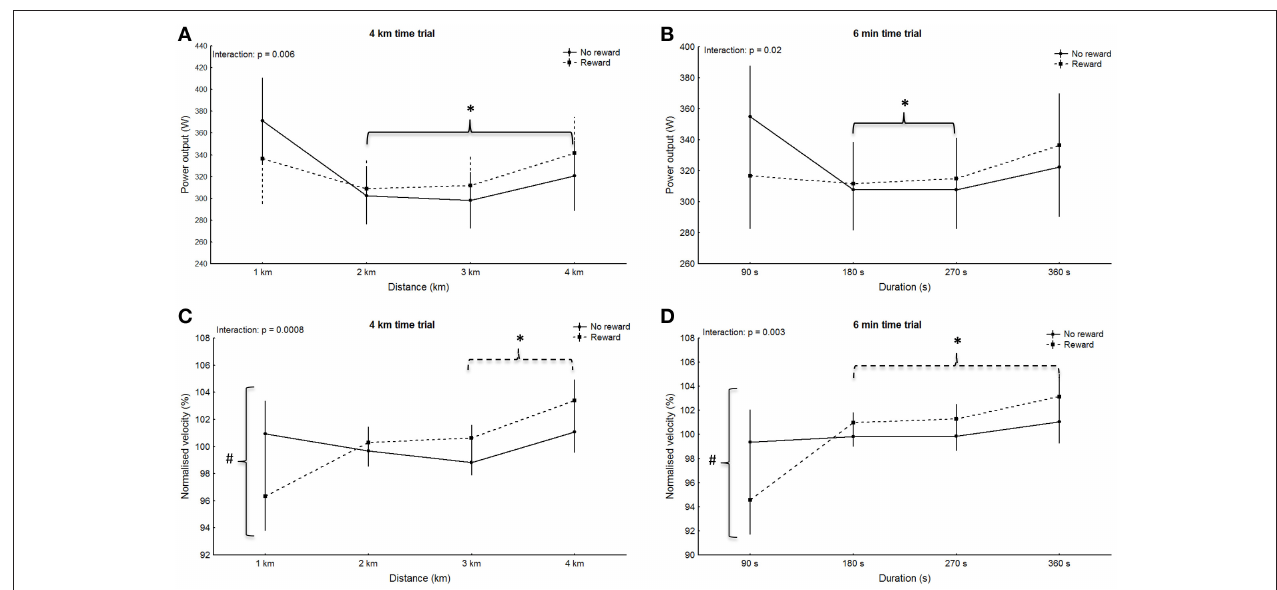
Main effects for split-by-group interaction were observed for the 4 km (G-G corrected: p < 0.001, F = 6.30, η 2 = 0.23; Figure 1C ), 6 min (G-G corrected: p = 0.003, F = 5.01, η 2 =